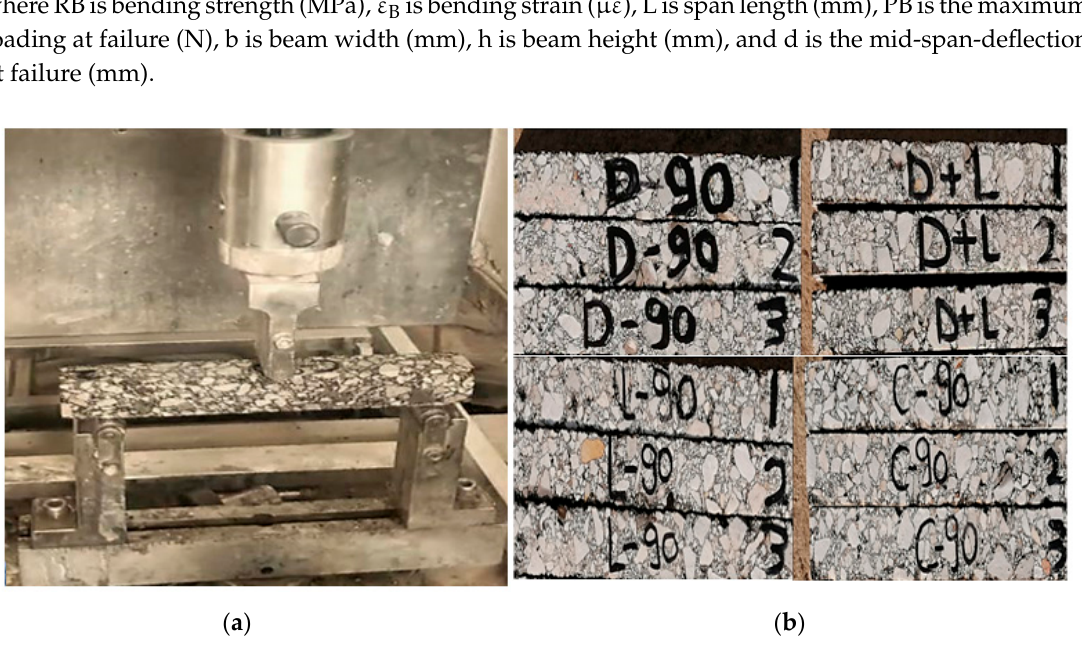
Figure 4. ( a ) Bending test machine; ( b ) samples of three-point bending test.